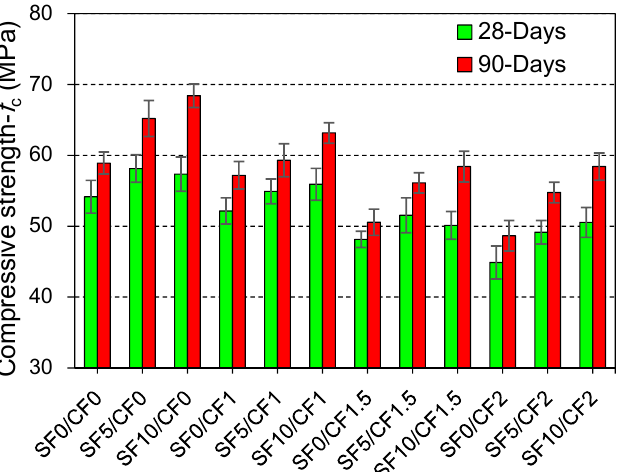
Figure 7. Effect of silica fume and coir addition on the compressive strength of HSC at 28 and 90 days.